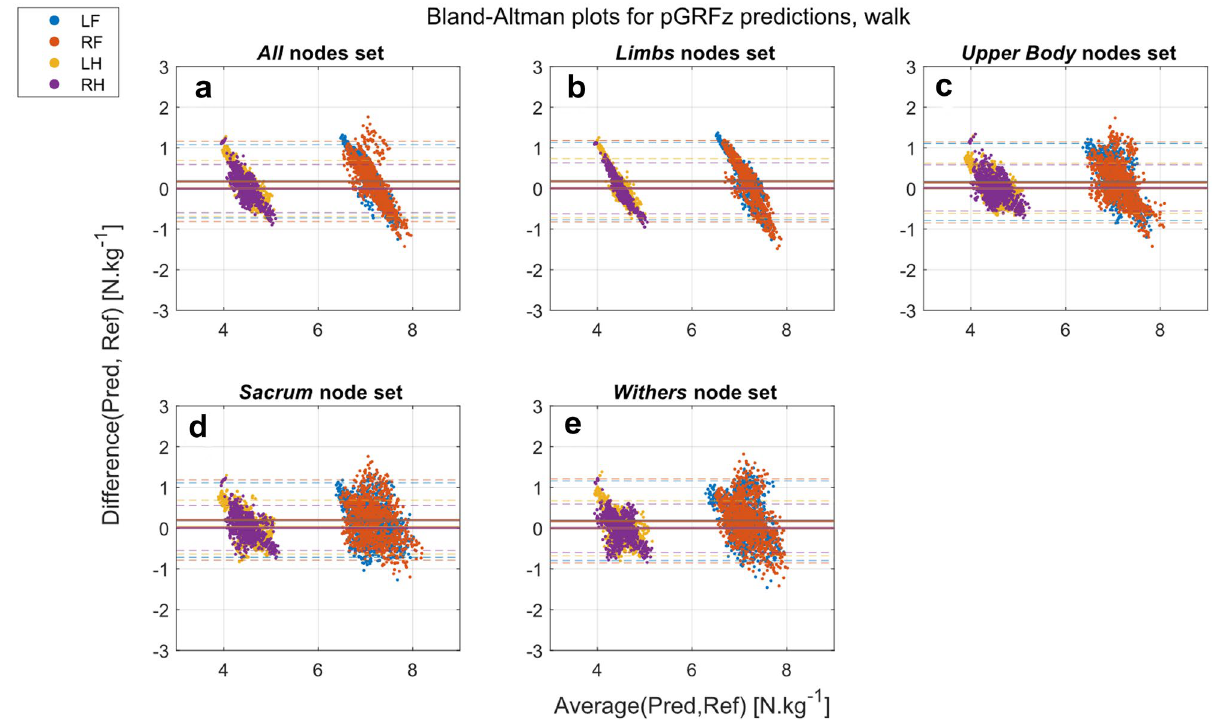
Figure 4. Bland–Altman plots of the predicted pGRFz by the different nodes sets at walk (Pred) against the reference values extracted from the TiF data (Ref): ( a ) All (head, withers, sacrum, and limb nodes); ( b ) Limbs (limb nodes); ( c ) Upper-body (head, withers and sacrum nodes); ( d ) Sacrum (sacrum node); ( e ) Withers (withers node). LF left front, RF right front, LH left hind, RH right